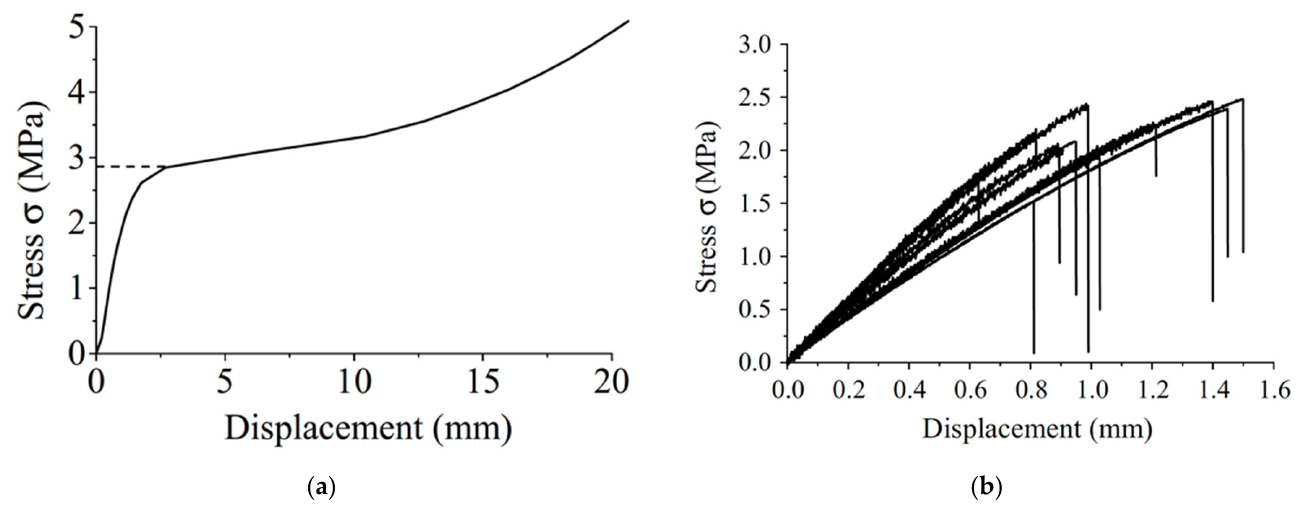
Figure 10. Stress-displacement plots for Korean Pine in ( a ) compression and ( b ) tension. From [85].